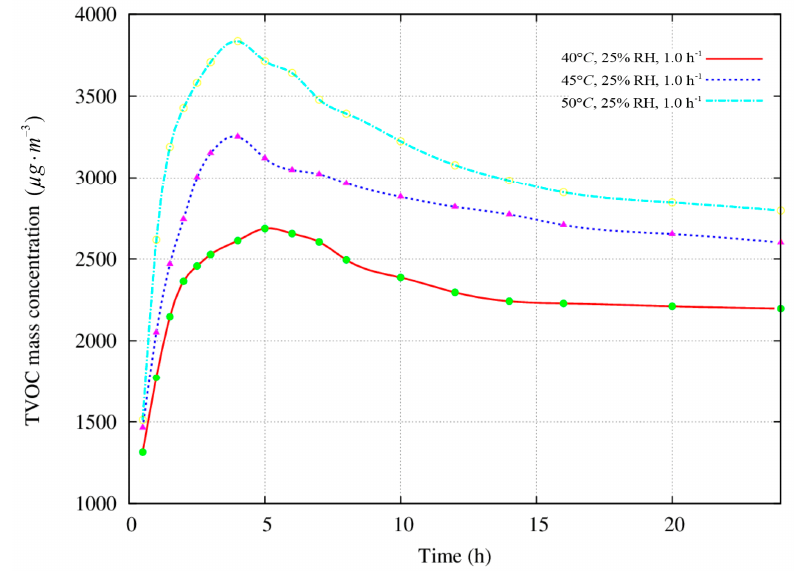
Figure 3. The TVOC mass concentration of PU athletics track changes with time from 40 to 50